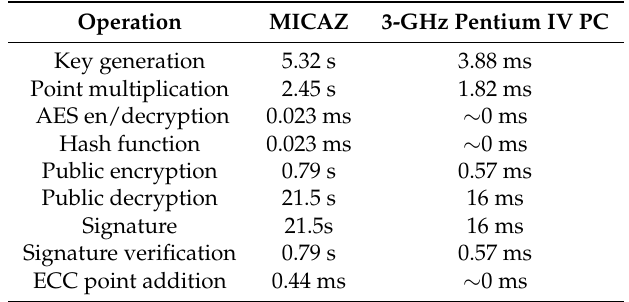
Table 3. Computational time of various cryptographic